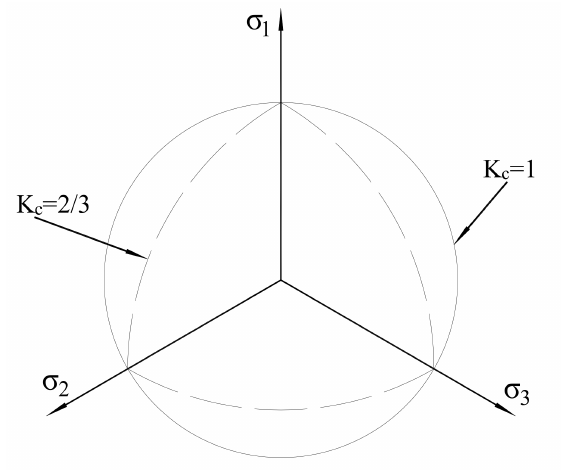
Figure 11. Yield surfaces in the deviatory